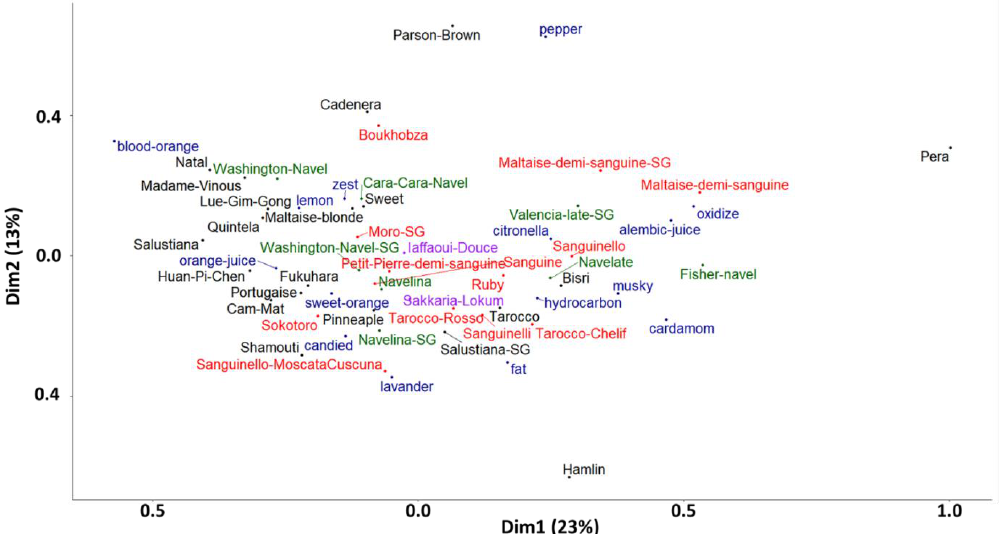
Figure 6. Correspondence Factor Analysis (CFA) representing the diversity of the 43 orange cultivars according to the 15 descriptors (represented in blue) of the aroma profiles of the essential oils is significantly different between cultivars according to the Cochran test ( p ≤ 0.05). ‘Blood’ cultivars are represented in red, ‘navel’ in green, ‘acidless’ in purple, and ‘blond’ cultivars in